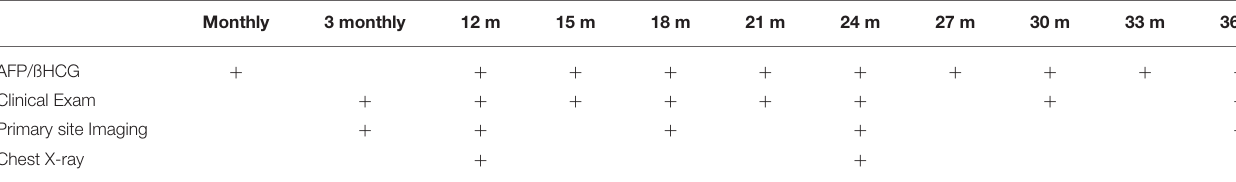
TABLE 1 | Recommended follow-up schedule following germ cell tumor